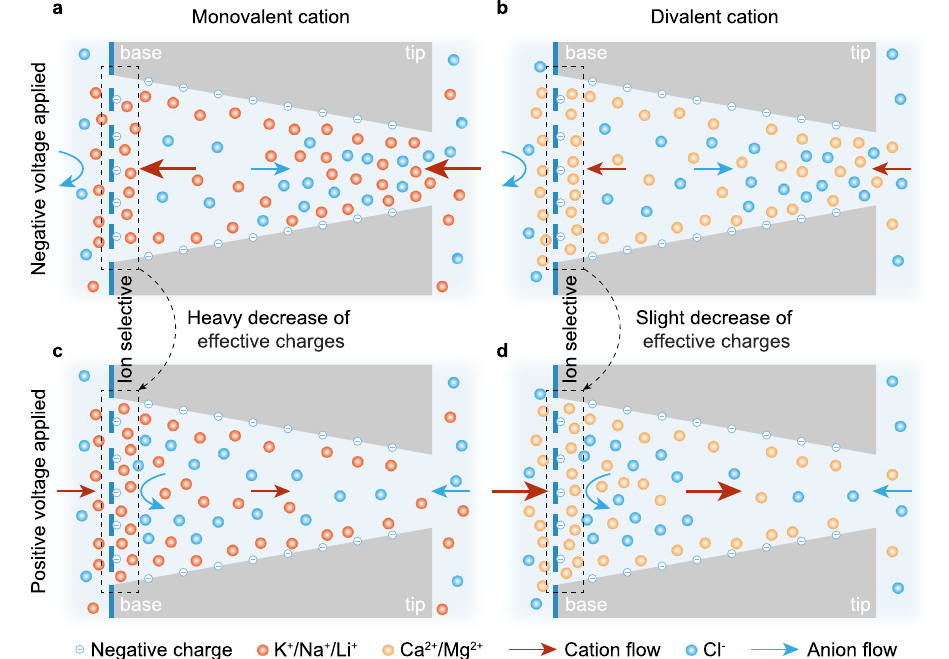
Fig.5|Schematicillustrationofthemechanismofionsievingandrecti fi cation in graphene-based polyethylene terephthalate nanochannel (GPETNC). The distribution and transport direction of anions and monovalent cations at negative voltages ( a ), divalent cations at negative voltages ( b ), monovalent cations at posi- tive voltages ( c ), and divalent cations at positive voltages ( d ). Ion selective gra- phenesubnanoporesareonthebasesideoftheconicalpolyethyleneterephthalate